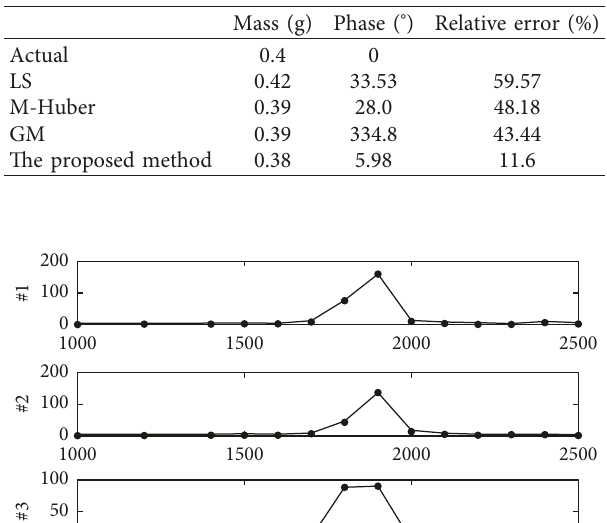
Table 1: The results of estimated unbalance mass.